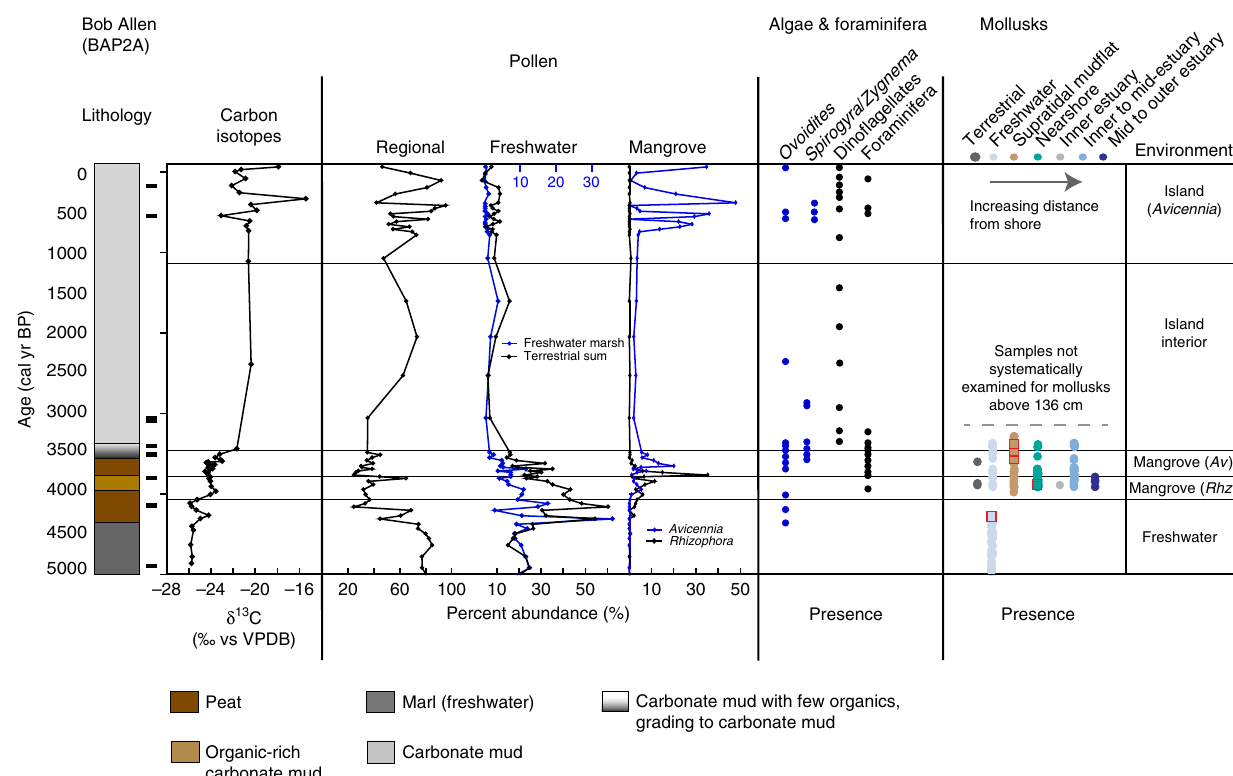
Fig. 2 Core summary diagram for Bob Allen Key (BA). Carbon isotopes, selected pollen groups, and presence of algal cysts, foraminifera and dino fl agellates, and mollusks. Regional pollen includes Pinus (pine) and Quercus (oak). Freshwater marsh sums include Poaceae, Cyperaceae, Nymphaea, Typha, Rhynchus, Cladium, Schoenoplectus, Sagittaria, Crinum , and Amaryllidaceae. Terrestrial sum includes all taxa except the regional taxa and mangrove taxa, as well as Batis maritima and Amaranthaceae. Presence of certain taxa include Ovoidites , Spirogyra (closed blue circles); dino fl agellates, foraminifera (black closed circles). Mollusk presence is shown in order of increasing salt-water/estuarine habitat and distance from shoreline from left to right. Red squares indicate abundance or dominance in a given sample. Radiocarbon age control shown by black rectangle next to the